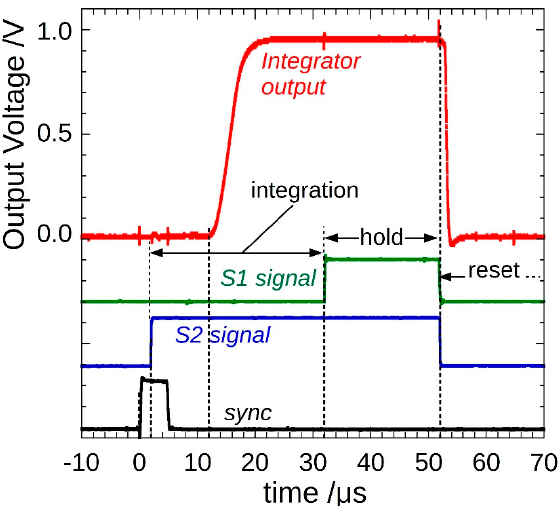
Figure 4. Typical gated-integrator output voltage signal (red). Integration performed by IVC102, controlled by S1 and S2 signals (green and blue, respectively), started a few μ s after the arrival of a pulse (sync signal, black). The system is ready for a new acquisition after 50 μ s.